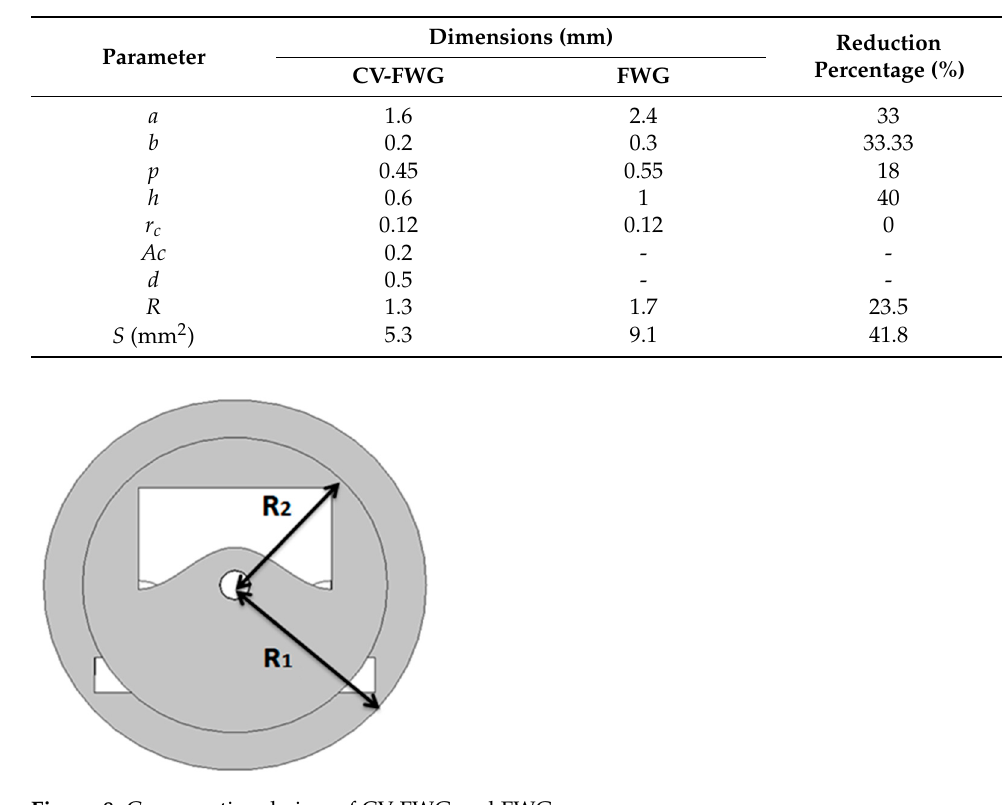
Table 2. Structure parameters and comparison.